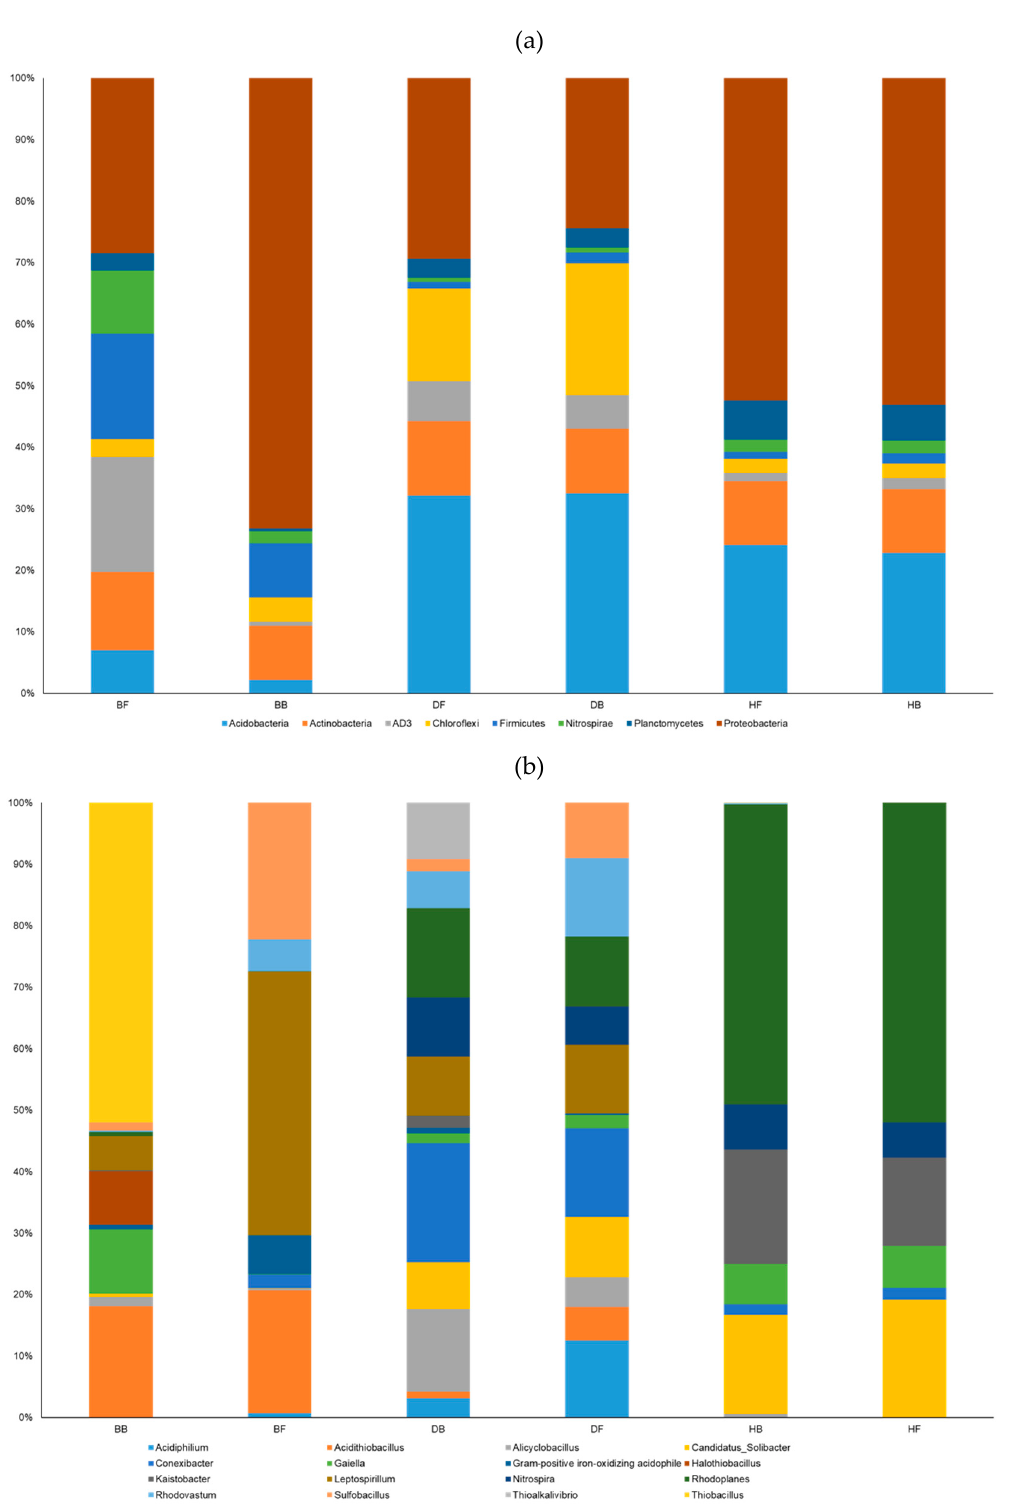
Figure 2. Relative abundance of the most abundant eightbacterial phyla ( a ) and 16 genera ( b ) in the contaminated soil samples. At the genus level, only those with proportions above 5% of the total reads in each sample are